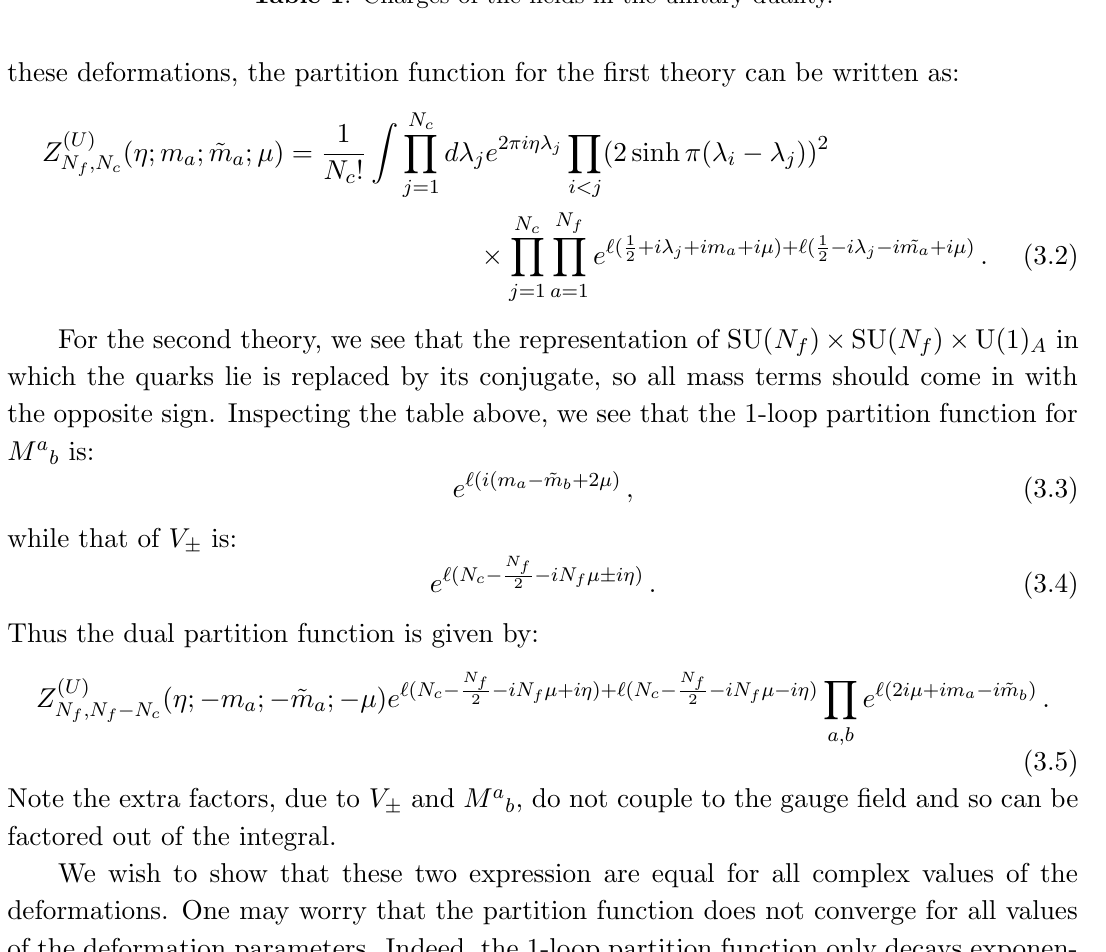
Table 1 . Charges of the (cid:12)elds in the unitary